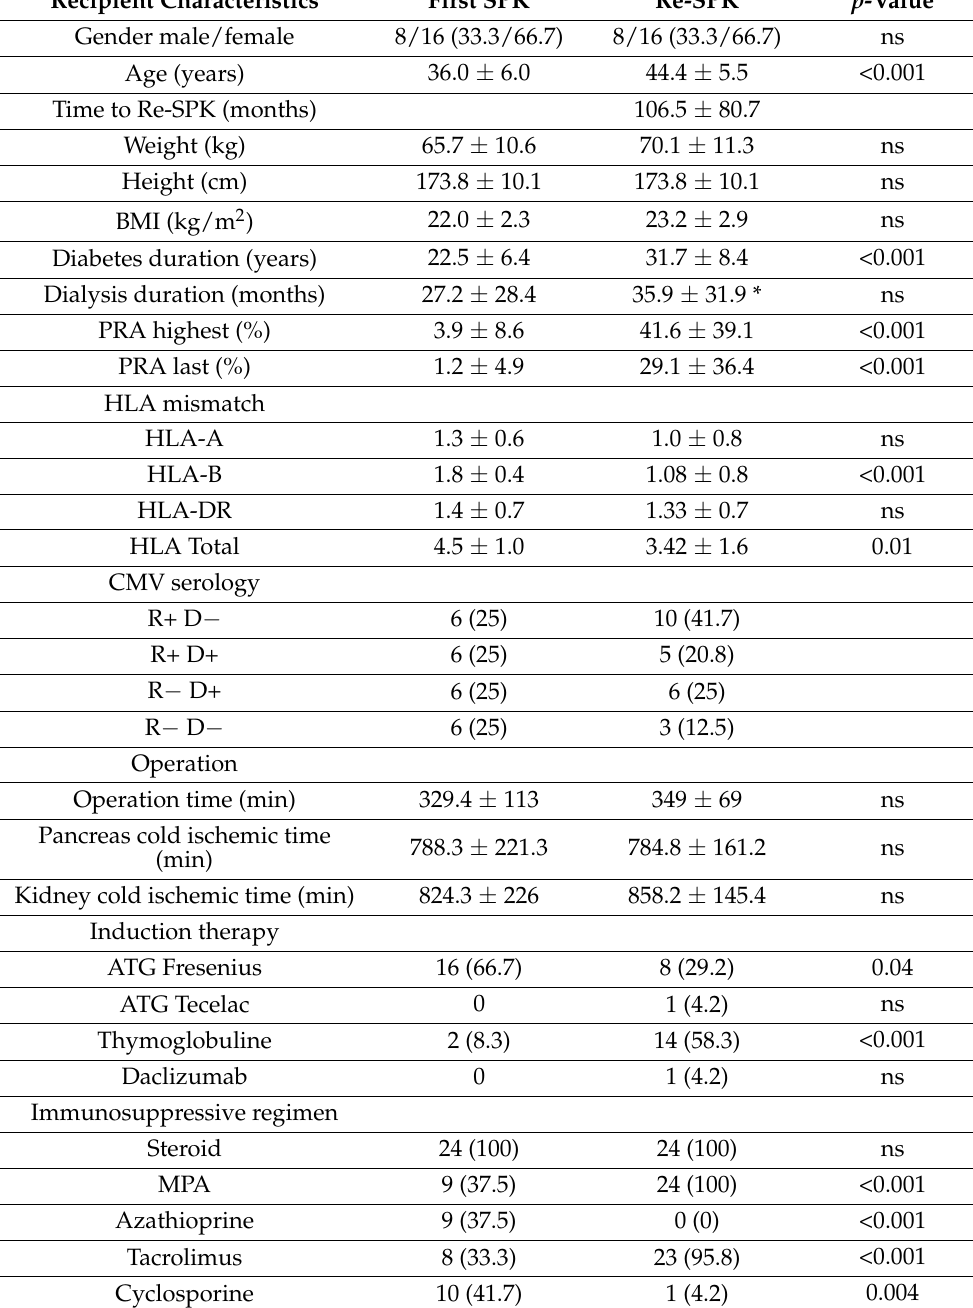
Table 1. Recipient